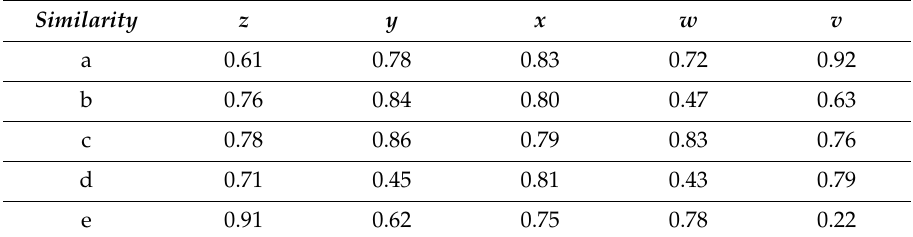
Figure 8. MMU obtained by moving O to O ’. Table 1. Similarity matrix between all triangles in MMU P and MMU O (cid:48)